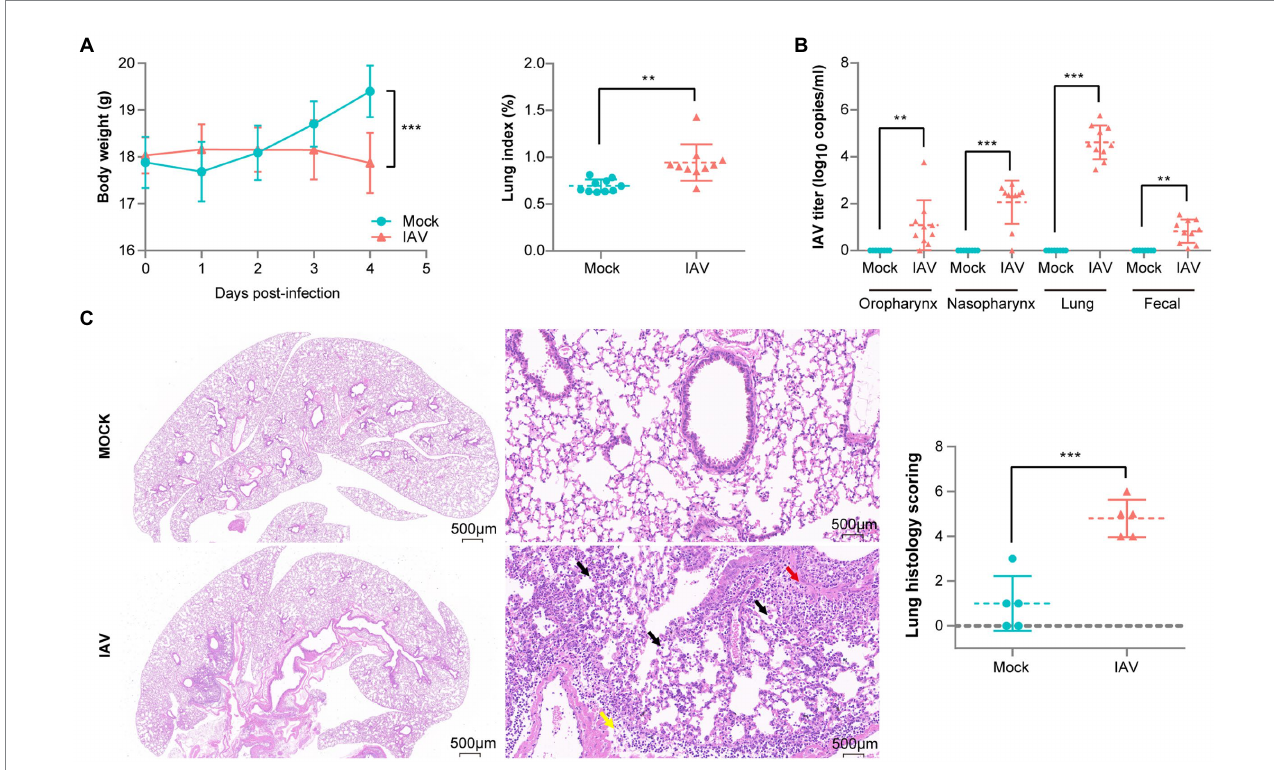
FIGURE 1 Pathological difference between mock-and IAV-infected mice. (A) Body weight and lung index ( n = 10 per group). (B) IAV titers of oropharynx, nasopharynx, lung and fecal samples ( n = 10 per group). (C) H&E staining and histologic scoring of right lungs ( n = 5 per group). Body weight, IAV titer and histologic scoring were compared by using unpaired t tests * p < 0.05, ** p < 0.01, *** p <